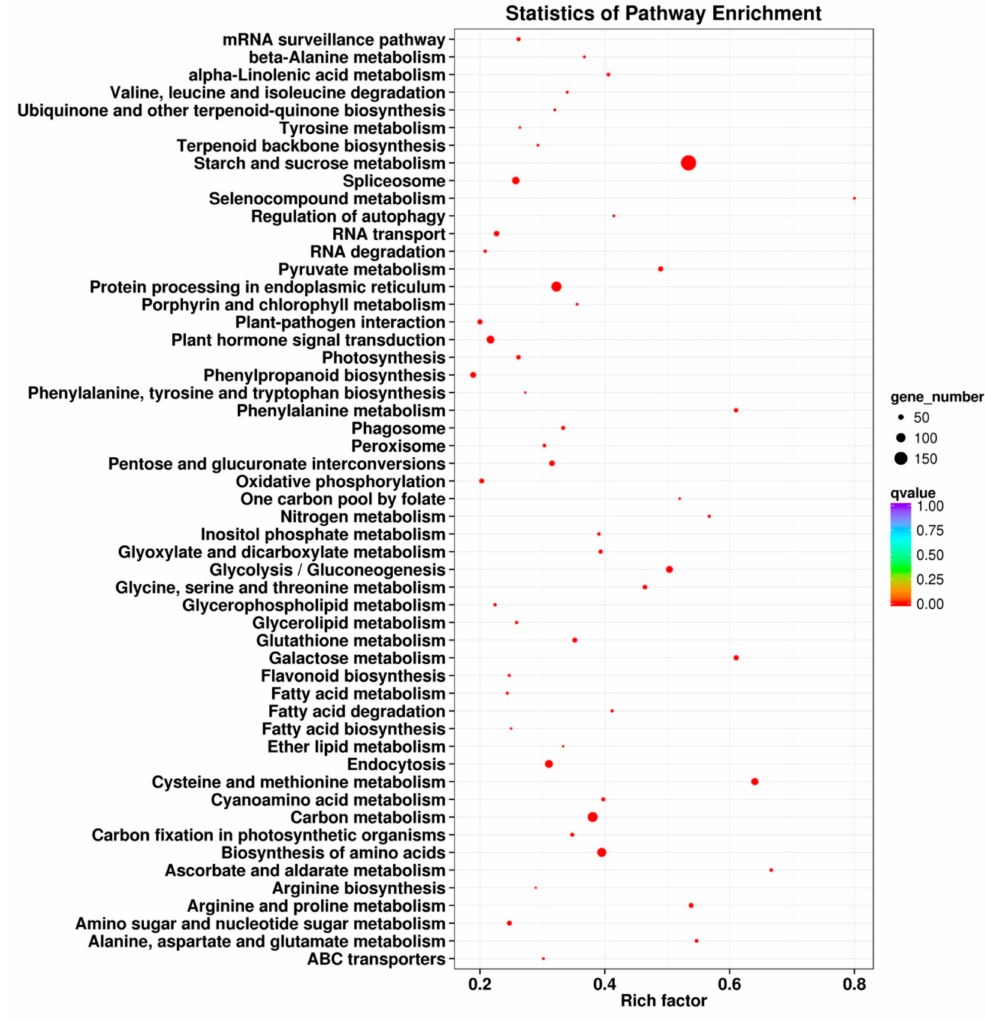
Figure 7. Kyoto Encyclopedia of Genes and Genomes (KEGG) pathway enrichment scatter diagram of DEGs. Only the most highly represented pathways are displayed in the diagram. The degree of KEGG pathway enrichment is represented by an enrichment factor, the FDR value, and the number of unigenes enriched in a KEGG pathway. The enrichment factor indicates the ratio of differentially expressed unigenes enriched in this pathway to the total number of annotated unigenes in this pathway. The names of the KEGG pathways are listed along the x-axis. The FDR value indicates the corrected p-value, ranging from 0 to 1, and an FDR value closer to 0 indicates a greater